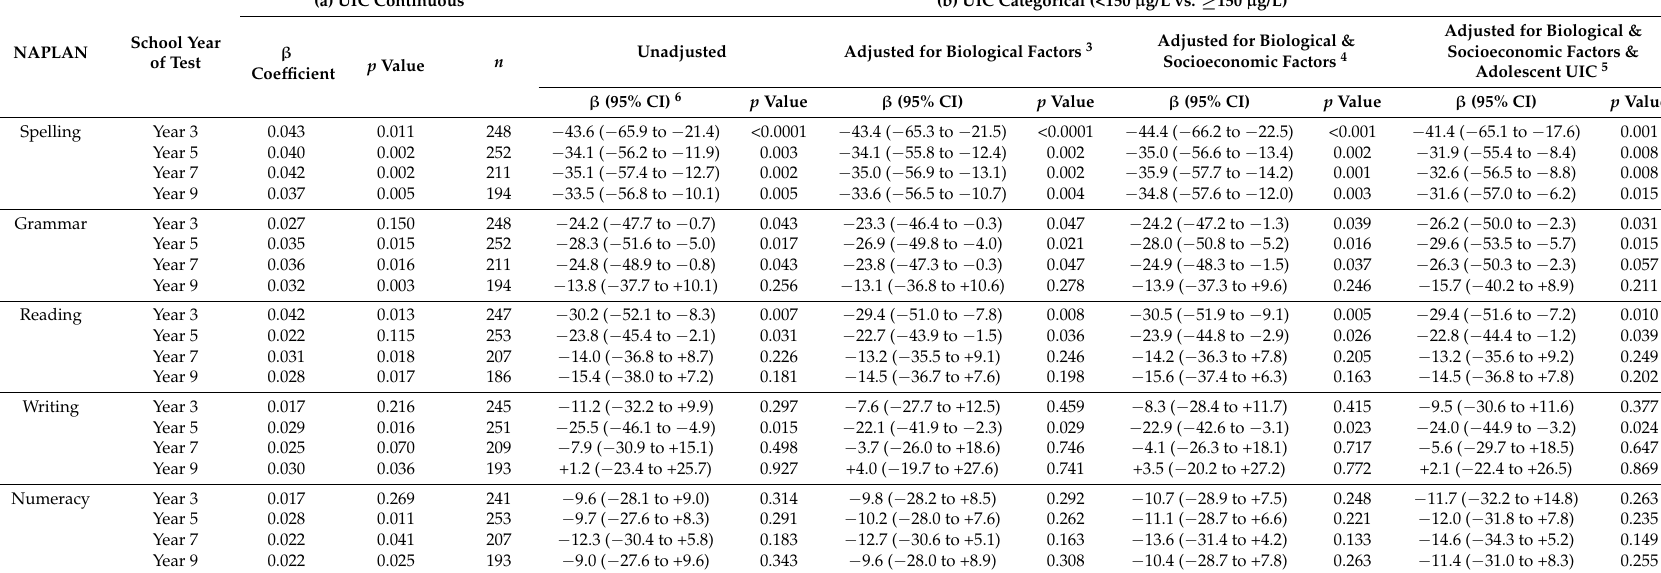
Table 3. ( a ) Examination of NAPLAN associations with maternal urinary iodine concentration (UIC) as a continuous variable, n = 266 1 . ( b ) NAPLAN mixed-effects multiple imputation using chained equations (MICE) 2 models: Differences in NAPLAN outcomes for offspring of mothers with deficient UIC (<150 µ g/L) during pregnancy compared to mothers with sufficient UIC ( ≥ 150 µ g/L), n =